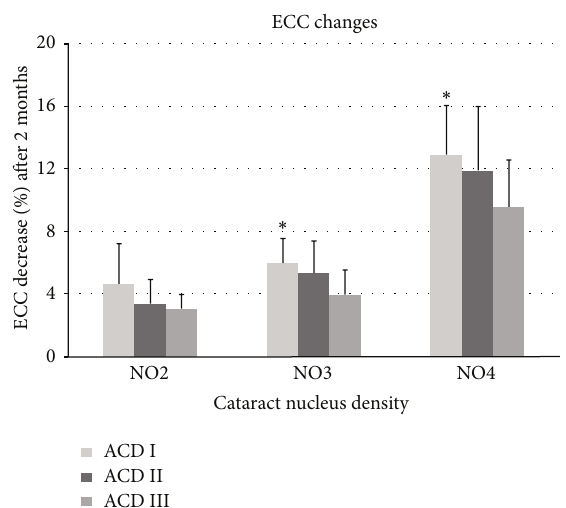
Figure 2: Postoperative endothelial cell loss by cataract nucleus density and ACD groups ( ∗ = significant in Bonferroni and Dunnett’s T3 as post hoc